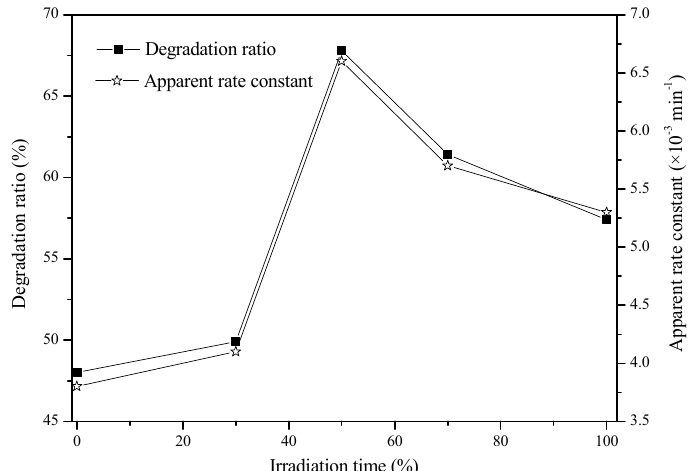
Figure 7. Chlorobenzene degradation ratio and apparent rate constant of Cu 2+ /K 2 La 2 Ti 3 O 10 at 500 °C as a function of CO 2 concentration.